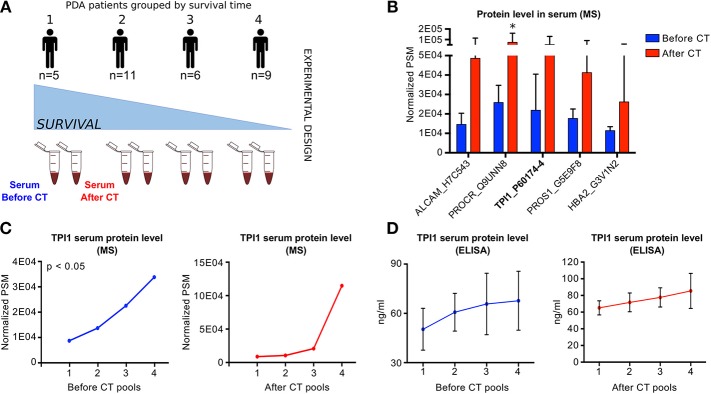
Proteomic analysis of PDA patients sera (A) Scheme of the experimental design of the free-circulating proteins proteomic analysis using pulled sera from PDA patients collected before and after chemotherapy (CT). Samples were divided in pools based on the months of disease-free survival. (B) Bar plot reporting the Peptide-Spectrum Matches (PSMs) of five circulating proteins associated with the highest log2 fold change between BCT and ACT samples. P-values were computed using Wilcoxon Rank-Sum test. *p < 0.05. (C) Line plot reporting the normalized TPI1 protein level measured in different pools of PDA patient sera collected before (left panel) or after CT (right panel). P-values were computed using Pearson correlation method. (D) Line plot reporting the normalized TPI1 protein level measured by ELISA assay applied on different pools of PDA patient sera collected before (left panel) or after CT (right panel).